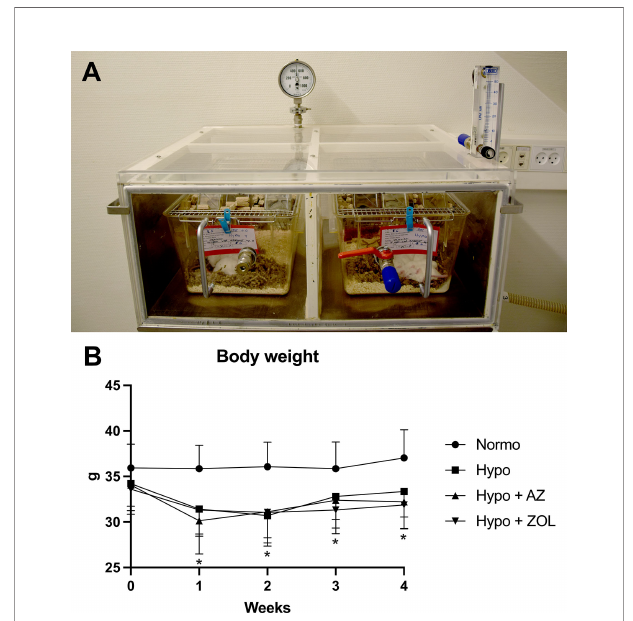
FIGURE 1 | (A) Setup of the hypobaric chambers used to expose mice to simulated high altitude (500 mbar, which approximately corresponds to the ambient pressure at 5,500 m above sea level). The pressure was controlled using an electric vacuum-pump located in another room to eliminate noise. (B) Development of body weight throughout the study. All data were analyzed using a one-way ANOVA. Data are presented as mean ± SD and n = 15 – 16/ group. * p < 0.05 vs.